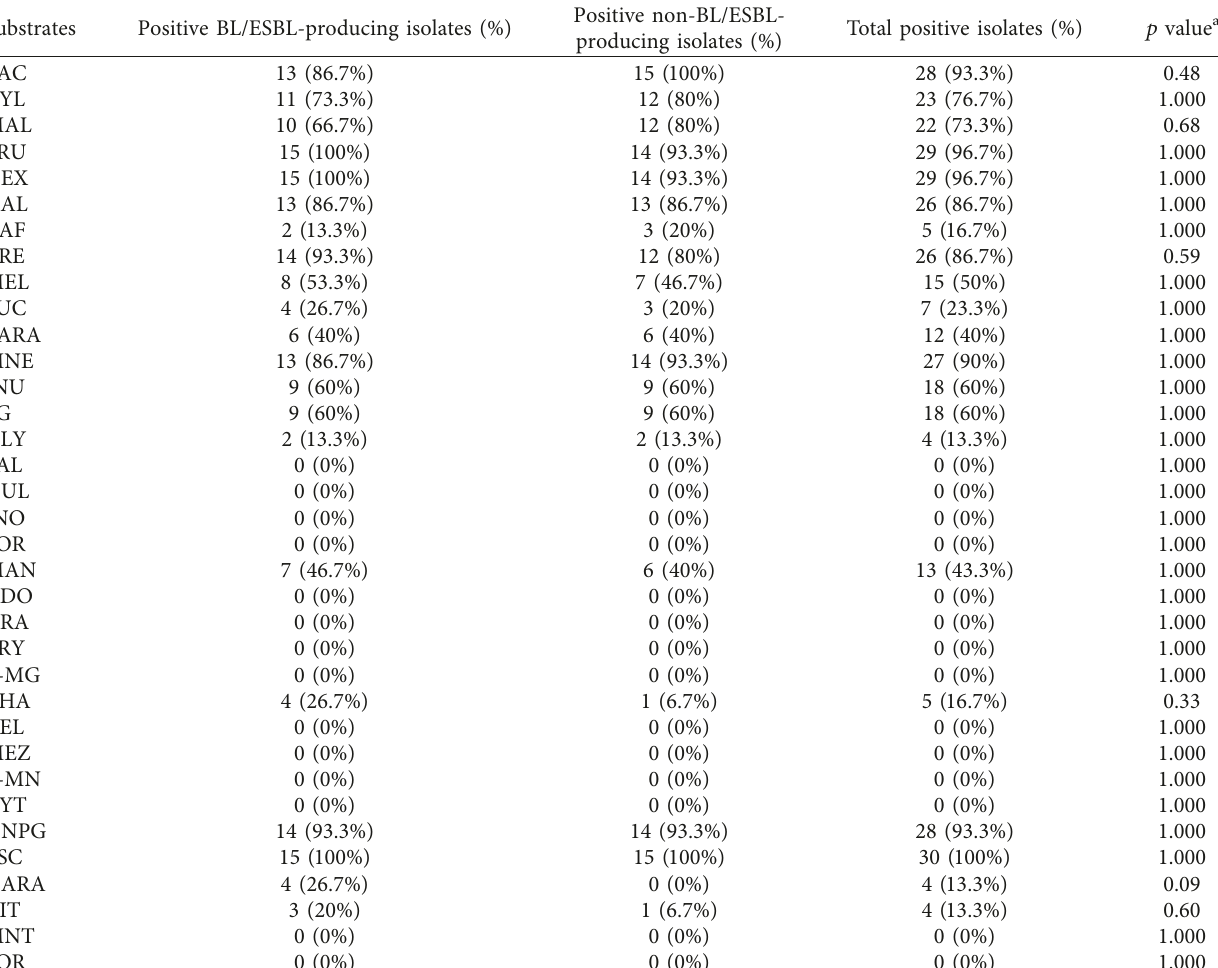
Table 3: Metabolic activity of BL/ESBL-producing and non-producing